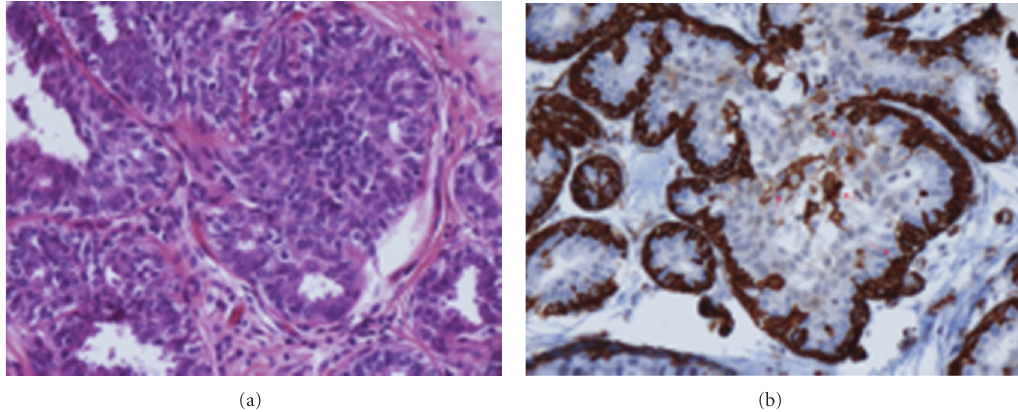
Figure 1: H.E. and immunoreaction for SM-actin—epitheliosis (usual ductal hyperplasia). Intraductal proliferation with irregular, “slit- like” lumina. The immunoreaction shows myoepithelial cells ( arrows ) surrounding the duct and in the proliferation.